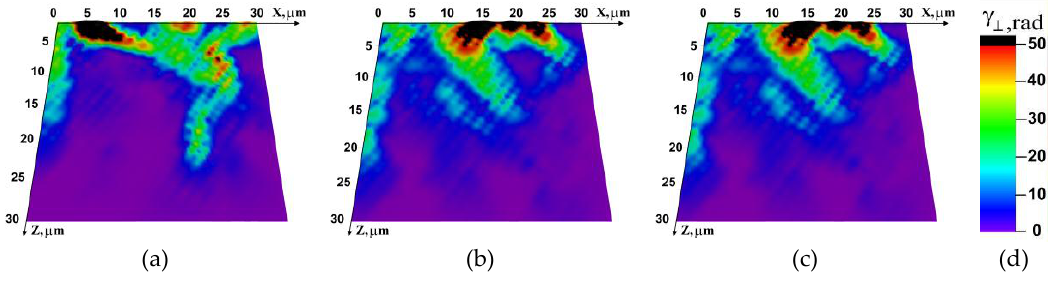
Figure 7. Relative rotation energy distribution on specimen faces at different temperatures at 500 μs after the beginning of loading. ( a ) −60 °C; ( b ) −20 °C; ( c ) 20 °C; ( d ) color legend.